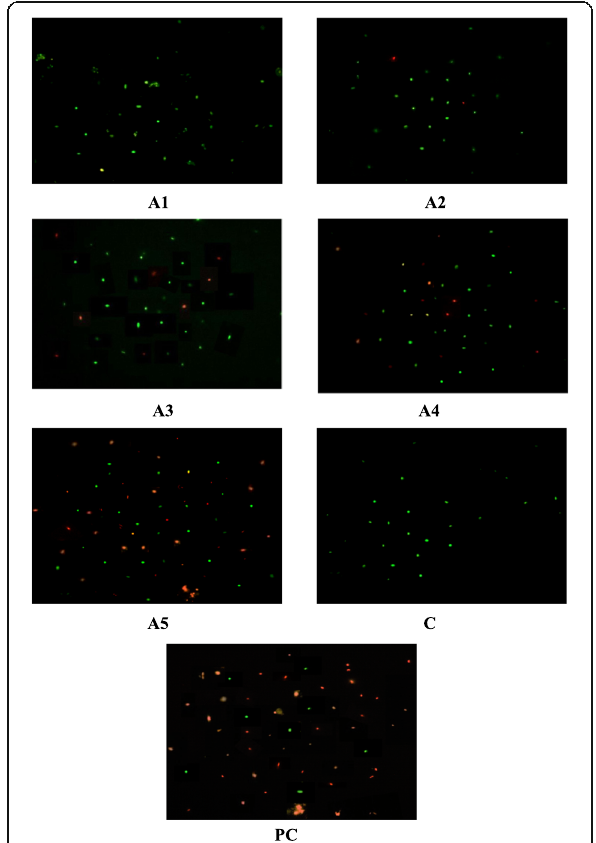
Fig. 4 Fluorescent staining of brain cells with acridine orange and ethidium bromide dye in the different groups visualised under the fluorescent microscope, (A1 = 5 μ M arecoline, A2 = 10 μ M arecoline, A3 = 20 μ M arecoline, A4 = 40 μ M arecoline, A5 = 80 μ M arecoline, C = Control, PC (Positive Control)= 10 μ l/ml methyl